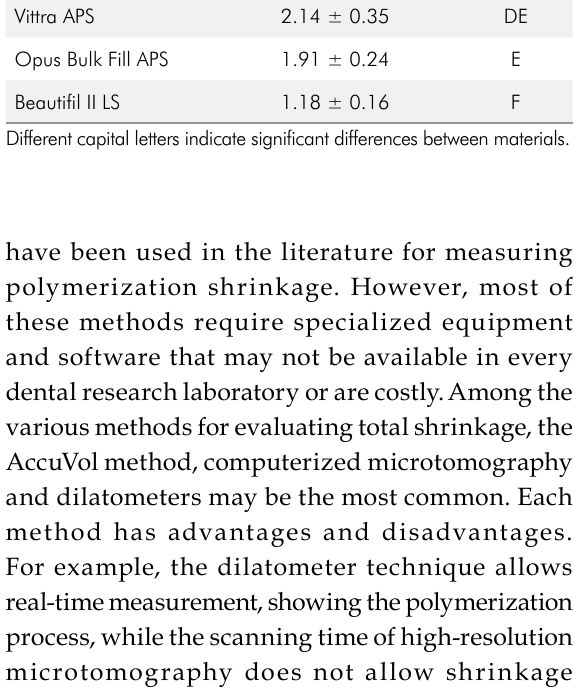
Different capital letters indicate significant differences between